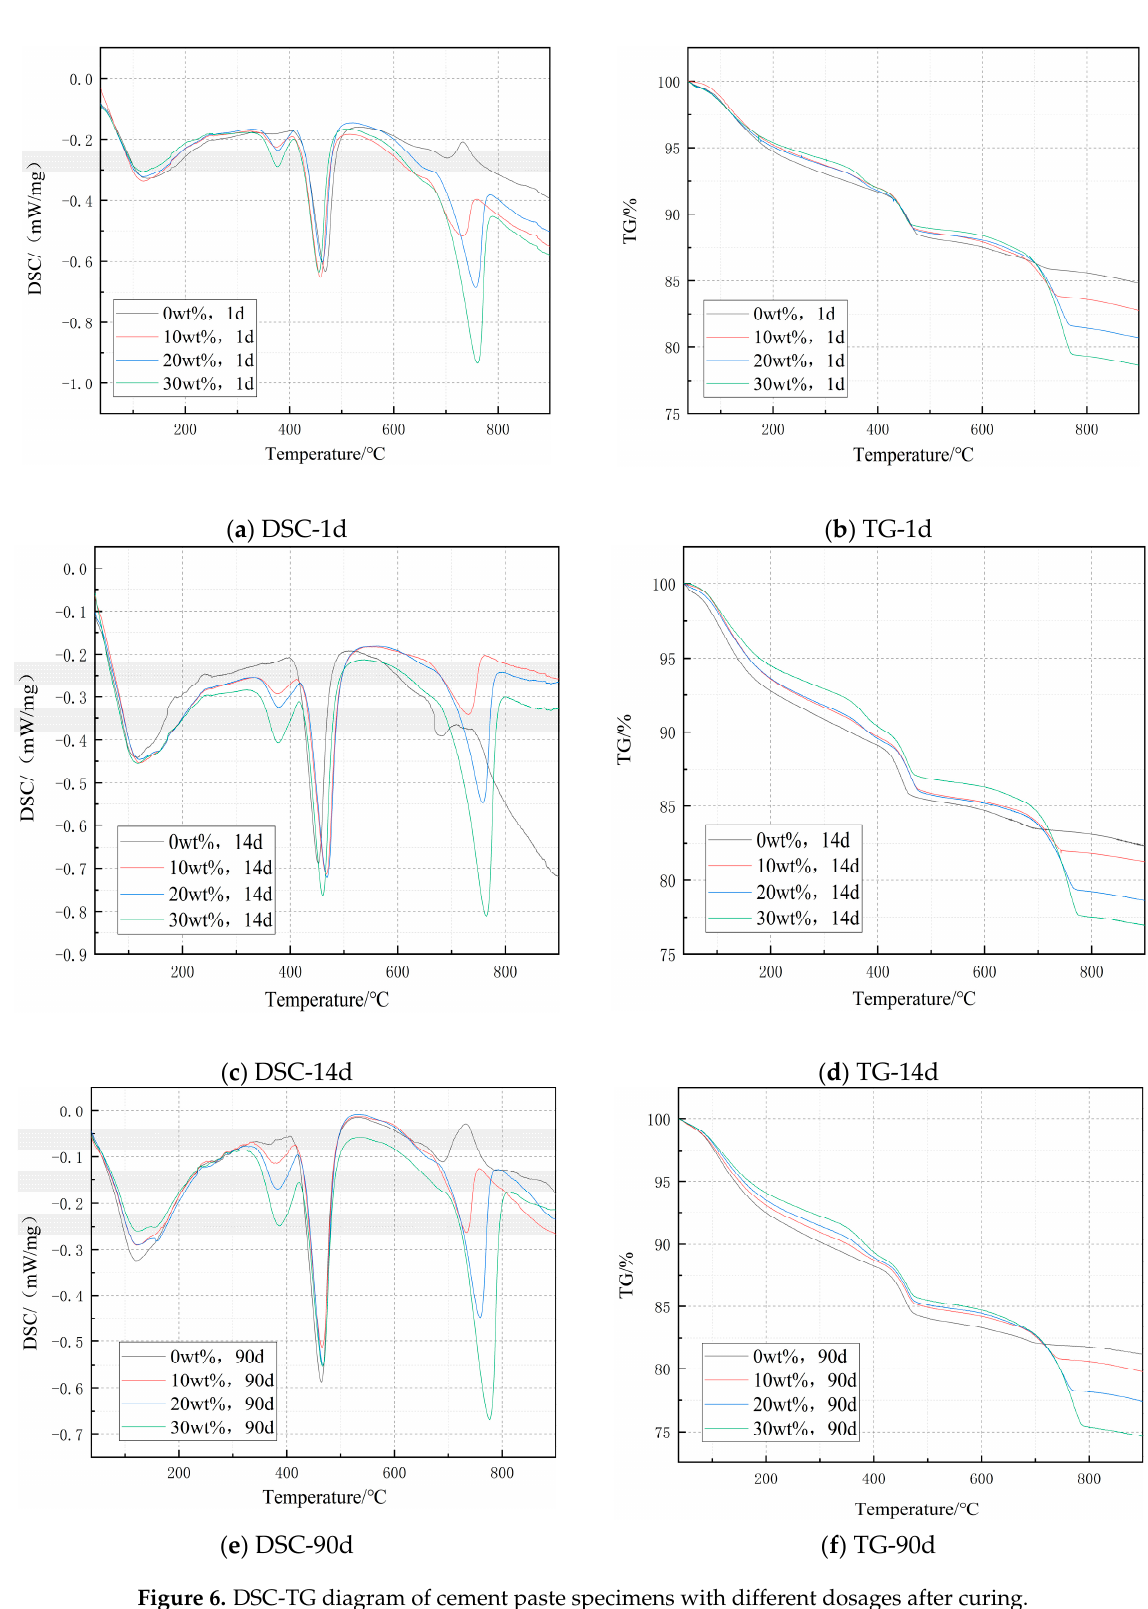
Figure 6. DSC-TG diagram of cement paste specimens with different dosages after curing. According to the TG curves shown in Figure 6, the mass loss of Mg(OH) 2 at this temperature can be known, and the amount of Mg(OH) 2 formed in cement paste and the hydration degree of MgO can be calculated by Equations (6) and (7).